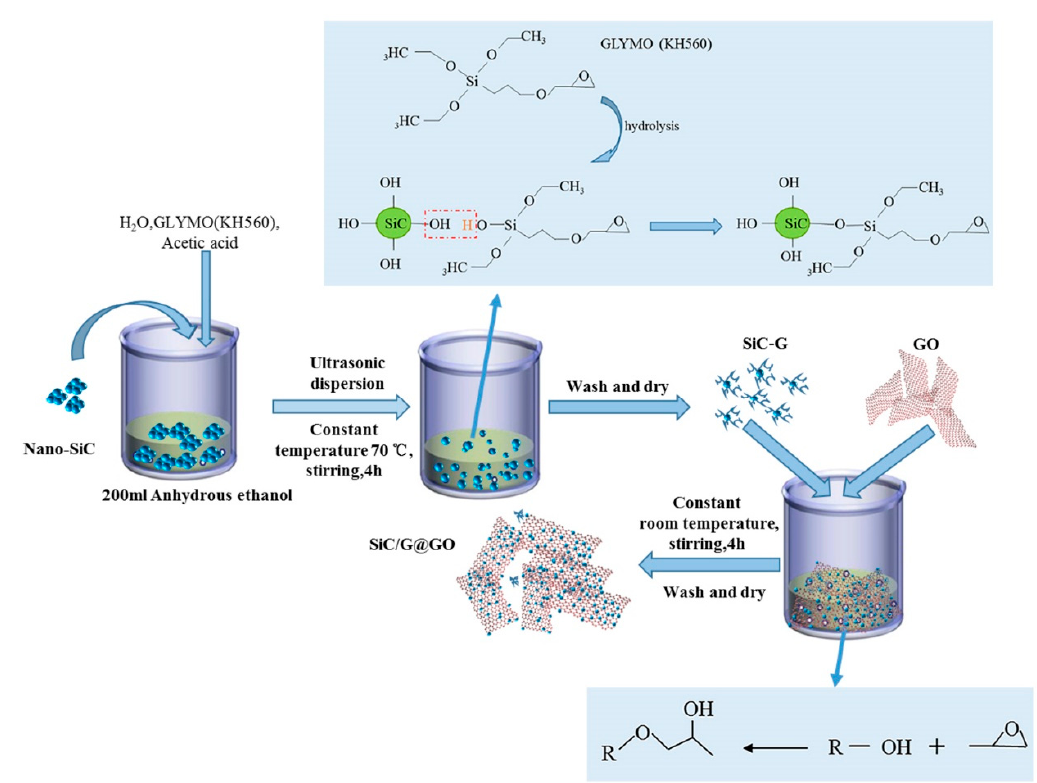
Figure 2. Schematic diagram of the preparation of the SiC-G@GO composite filler.